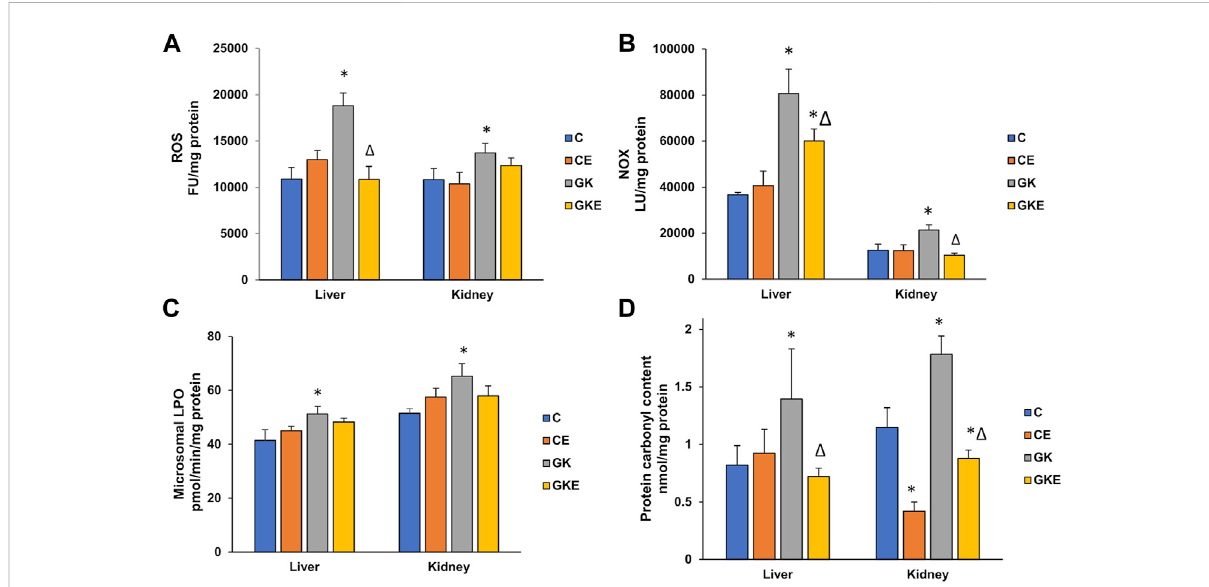
FIGURE 1 Exercise-inducedalleviationinROSandNOXproduction,lipidandproteinoxidationintheliverandkidneyofcontrolWistar(C)anddiabeticGK (GK)andexercise-trainedcontrol(CE)andGK(GKE)rats( n =5).Attheendoftheexercisetrainingfor2months,theliverandkidneytissuescollected from control and GK rats from each of the sub-groups were homogenized and analyzed for ROS production (A) measured using 2 ′ , 7 ′ -DCDF fl uorescence assay, membrane-bound NOX production (B) measured using the lucigenin-based assay as described in the Materials and Methods. Microsomal lipid peroxidation (C) was measured by the thiobarbituric acid method using malondialdehyde as standard and protein carbonylation (D) wasmeasuredusing dinitrophenylhydrazine(DNPH)as substrate. Histogram values aremean ± ofthree independentexperiments and statistical signi fi cance is shown as asterisks, which was fi xed as p < 0.05 (* indicates statistical signi fi cance compared with control Wistar rat tissues while Δ indicates statistical signi fi cance compared with diabetic GK rat